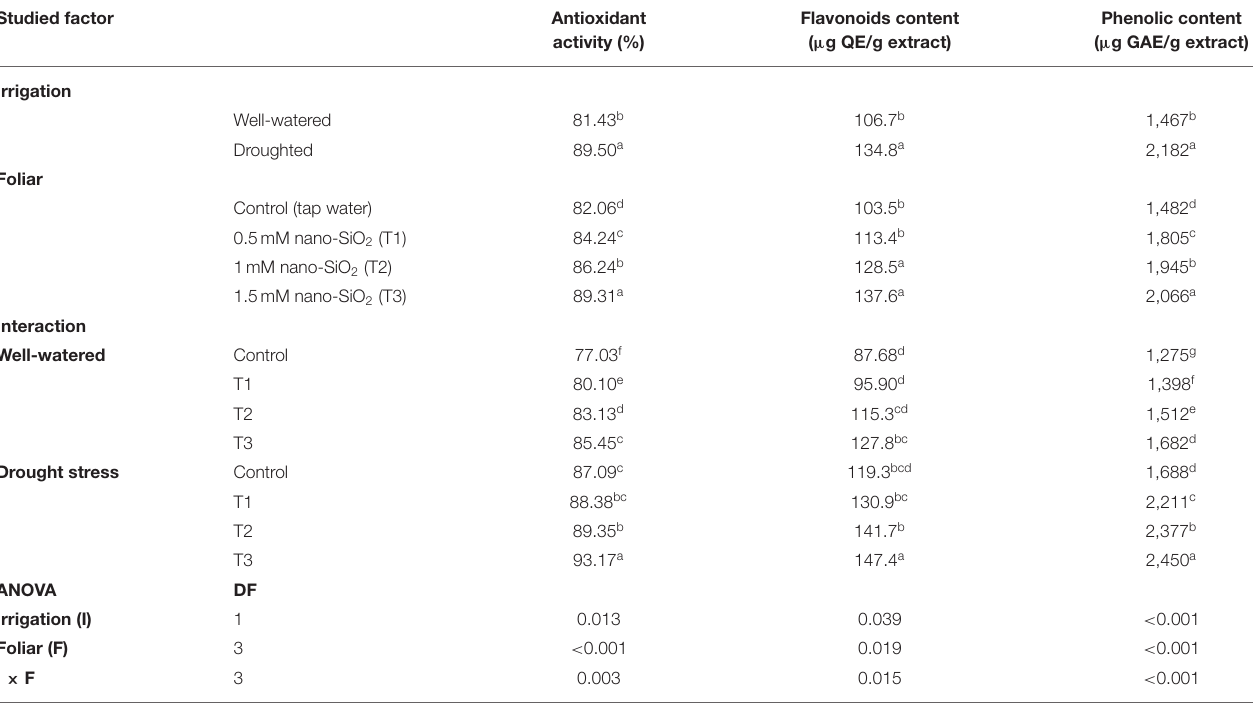
TABLE 4 | Impact of nano-silicon dioxide (nano-SiO 2 ) foliar application on antioxidant activity (%), flavonoids content ( µ g QE/g), and phenolic content ( µ g GAE/g) of faba beans ( Vicia faba ) under well-watered or drought-stressed conditions. Studied factor